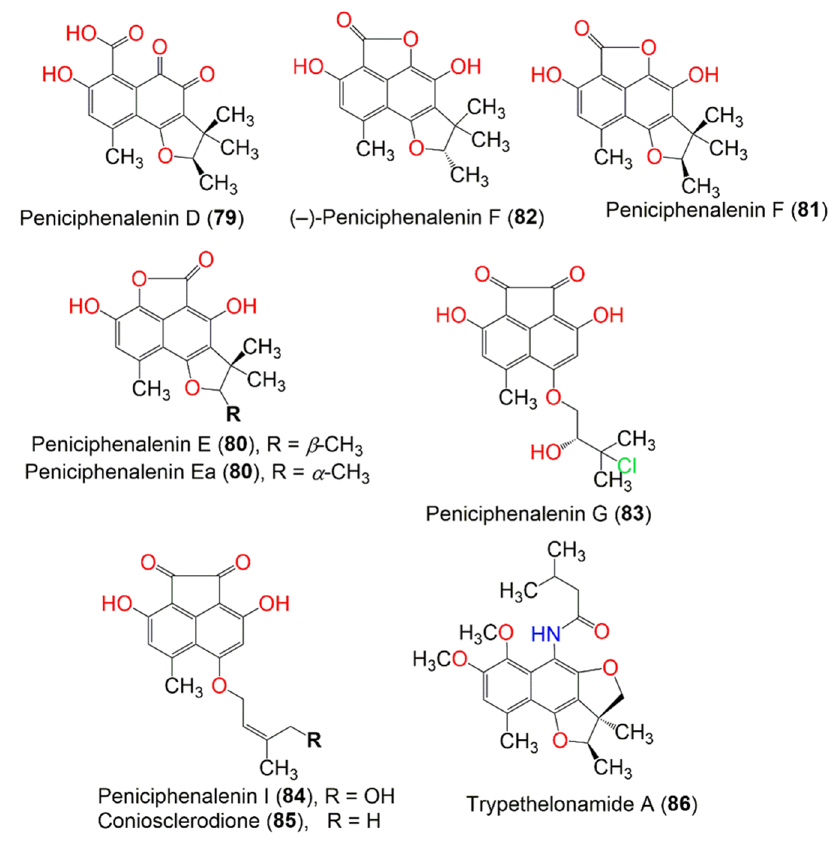
Figure 9. The structures of compounds 73 – 86 . Han et al. separated three new red-colored phenalenone derivatives, peniciphenalenins G–I ( 83 , 31 , and 84 ), along with coniosclerodione ( 85 ) and ( − ) sclerodinol ( 24 ) from the marine sediment-derived fungus, Pleosporales sp. HDN1811400, using UV-HPLC guided investigation. Their absolute configurations were determined by detailed spectroscopic and ECD analyses, in addition to the chemical method. Compound 83 was the first ex- ample of a chlorinated phenalenone derivative. Compounds 24, 31 , 83 , and 85 showed antimicrobial potential versus B. cereus, Proteus sp., M. phlei, B. subtilis, V. parahemolyticus, E. tarda, MRCNS, and MRSA (MICs 6.25–50.0 µ M). Compound 85 (MIC 6.25 µ M) was more active than compound 84 , indicating that 19-OH reduced the activity. Notably, compounds 24 , 31 , 83 , and 85 showed better inhibitory potential toward MRCNS and MRSA than that of ciprofloxacin, indicating their potential regarding drug-resistant strains [44]. Basnet et al. reported the isolation of a new yellow compound, trypethelonamide A ( 86 ), and a new dark violet-red compound, 5 (cid:48) ,-hydroxytrypethelone ( 87 ), along with a dark violet-red metabolites (+)-8-hydroxy-7-methoxytrypethelone ( 88 ), (+)-trypethelone ( 89 ), and ( − )-trypethelone ( 90 ) from the cultured lichenized fungus Trypethelium eluteriae by using Sephadex LH-20, ODS, SiO 2 , and HPLC. They were fully characterized via spectroscopic and ECD spectral analyses (Figure 10). They showed moderate to weak cytotoxicity versus the RKO cell line (IC 50 ranged from 22.6 to 113.5 µ M), compared to taxol (IC 50 0.05 µ M) in the CCK8 assay, while they had no antioxidant potential in the DPPH assay (concentration 200 µ M)